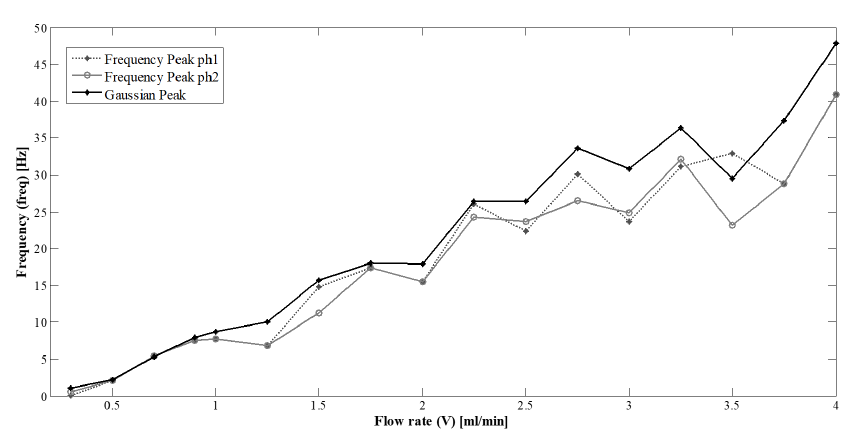
Figure 4. Experimental characterization of the slug flows by the frequencies of the slugs passage. Comparison among the peaks computed by automatic peak detection algorithm based on the Gaussian fitting (black solid line) and visual inspection of the spectra for the two photo-diodes acquisitions (black dashed lined and gray solid